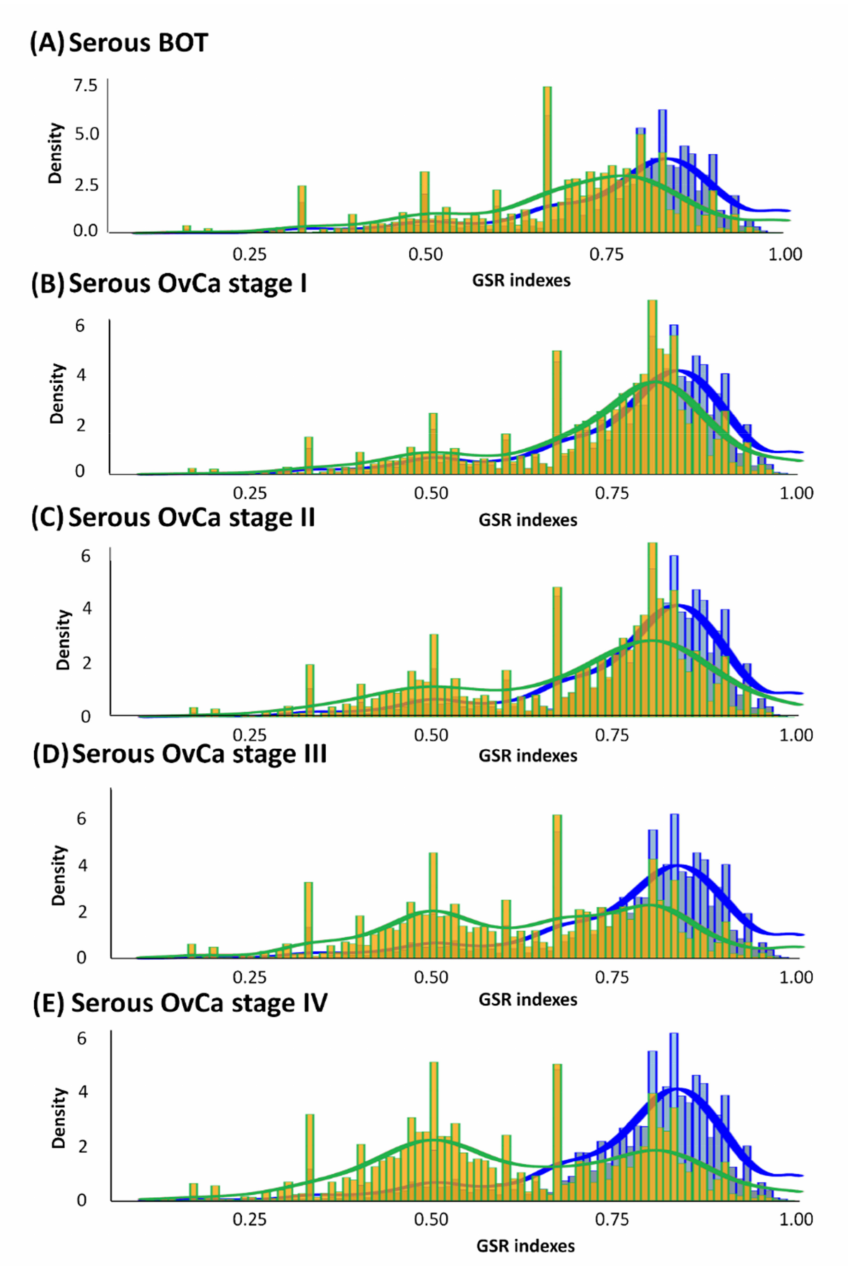
Figure 2. Histograms of global GSR indices of functionomes for serous BOTs, all stages of serous ovarian carcinomas (yellow green), and control groups (blue). Different distributions of the func- tionomes among five case sample groups and control groups are shown with statistical significance ( p < 0.05). The normal control group (blue, right) was used as the control and is the same in all panels. Peaks in distribution were observed (yellow green), indicating dysregulated biomolecular functionomes of serous BOTs and all stages of serous ovarian carcinomas. ( A – E ) Corrected GSR indices of serous BOTs: 0.7036 ( A ); FIGO stage I: 0.7230 ( B ); FIGO stage II: 0.6976 ( C ); FIGO stage III: 0.6355 ( D ); and FIGO stage IV: 0.6147 ( E